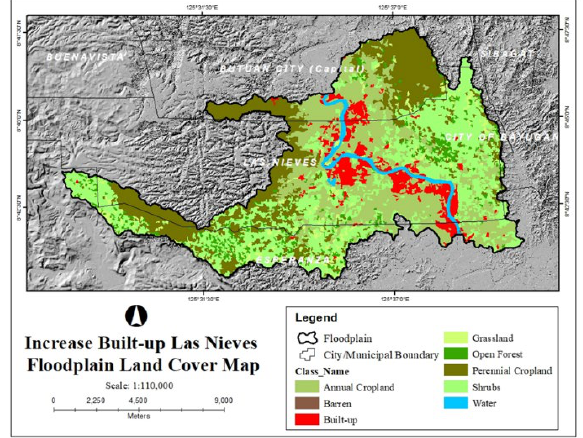
Figure 6. Increase built-up scenario of Las Nieves floodplain.